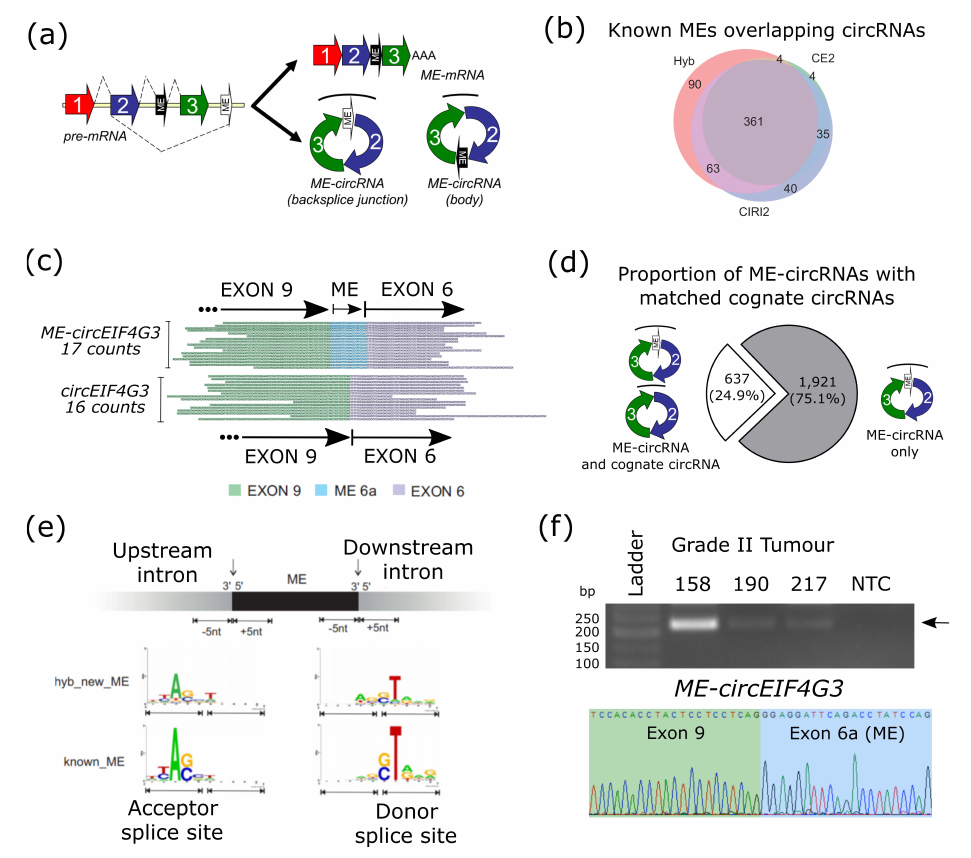
Figure 2. Microexons are included in circRNAs. ( a ) Incorporation of microexons (ME), which are defined here as 3-30 nt sequences into mRNA and circRNA. Note that MEs in circRNAs can fall into the backsplice junction (unfilled exon) or into the body (filled exon) of the circRNA. ( b ) circRNAs overlapping known microexon sequences for three pipelines. ( c ) Trimmed reads mapped to EIF4G3 which cover the circRNA backsplice junction across exon 9 and exon 6 ( circEIF4G3, 16 counts ) and the same junction with a 21nt ME ( ME-circEIF4G3 , 17 counts) from healthy brain tissue from patient #170. ( d ) De novo identification of ME-circRNAs using Hyb. Pie chart showing proportion of ME-circRNAs with matched cognate circRNA (637 / 2558; 24.9%) and orphan ME-circRNAs (1921 / 2558; 75.1%). ( e ) Sequence motif enrichment using WebLogo (ver2.8.2) around splice sites of predicted (upper) and known (lower) MEs in ME-circRNAs. The lines under each graph indicates the 5 nt of the intron side and the exon side of the ME splice site with the upstream acceptor splice site on the left and the downstream donor splice site on the right. ( f ) Upper, Agarose gel showing RT-PCR amplification of ME-circEIF4G3 in RNA from tumor samples #158, #190 and #217 and absence in non-template control (NTC). Lower, Sanger sequencing of PCR product across backsplice junction between the ME (blue shading, exon 6a) and exon 9 (green